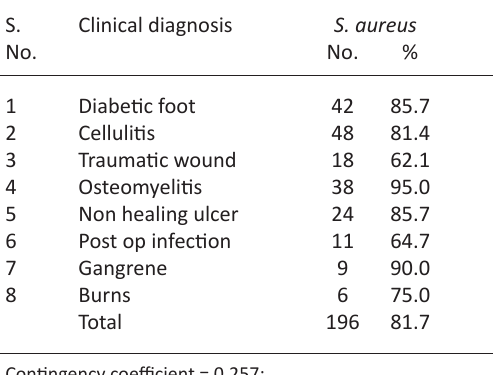
Table 3. Distribution of Staphylococcus aureus among clinical samples